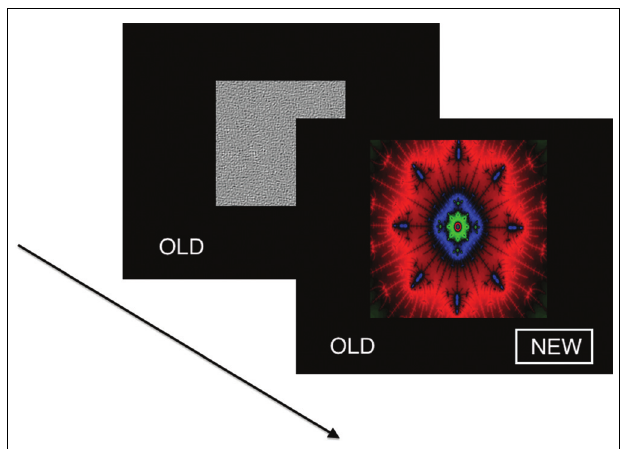
FIGURE 1 | Visual recognition task. In each of 60 trials, a unique fractal image was presented in a forced choice recognition memory paradigm. Half of the fractals had been previously displayed once each as salient distractors during a visual oddball task performed ∼ 10 min earlier, yielding 30 targets and 30 foils. Stimuli were presented for 3 s in a fast event-related design, with a variable 0–18 s interstimulus interval during which a homogeneous visual noise gray background was